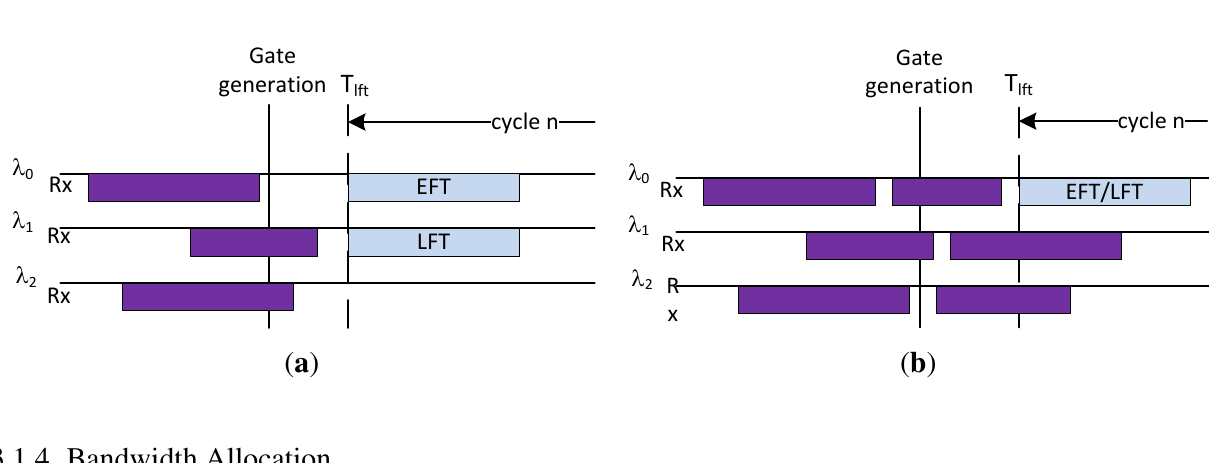
Figure 3. Wavelength Allocation. ( a ) EFT operation; ( b ) LFT